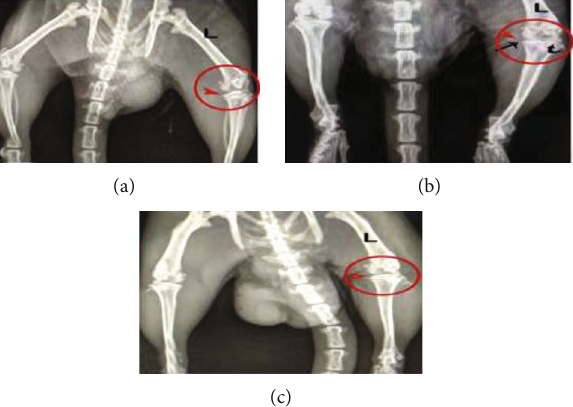
Figure 3: Radiographic changes in the left knee joint (L). (a) The normal control group shows a healthy knee joint with a smooth articular cartilage surface and normal joint space (arrowhead). (b) The MIA-treated group demonstrates OA alternations such as a remarkable narrowing of the joint space (arrowhead), erosion, subchondral sclerosis (curved arrow), and osteophyte (black arrow). (c) The MIA +BMMSC-treated group shows nearly restored normal joint space (arrowhead) and cartilage surface. Table 3: E ff ect of BM-MSCs on serum levels of TNF- α , IL-6, IL-10, and TGF- β of MIA-induced OA.